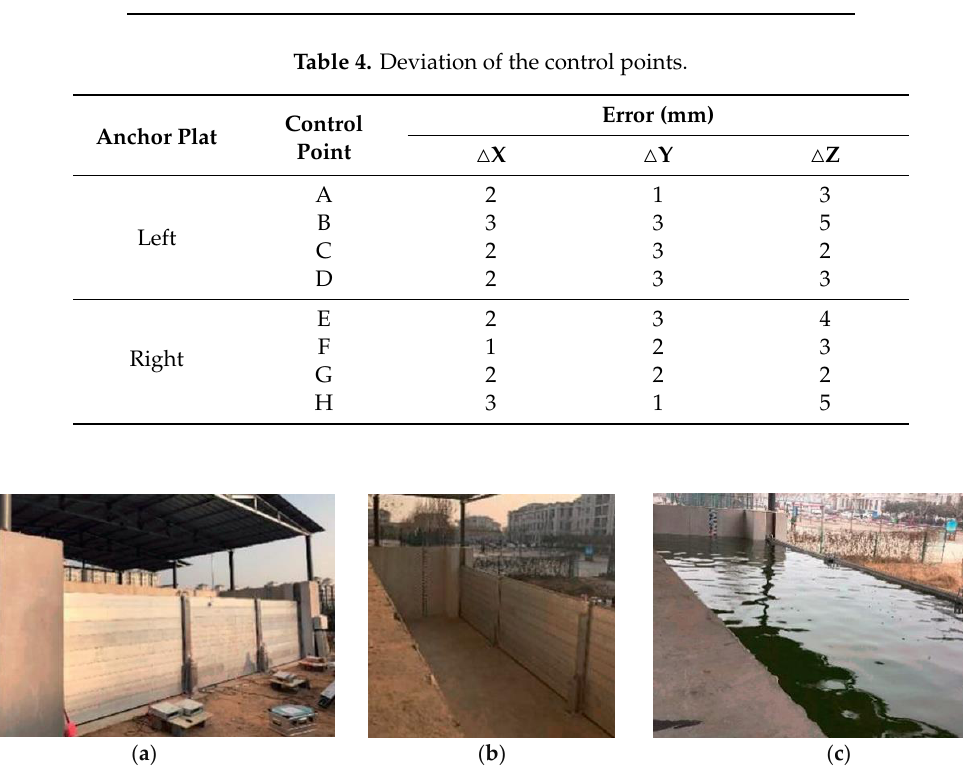
Table 4. Deviation of the control points.